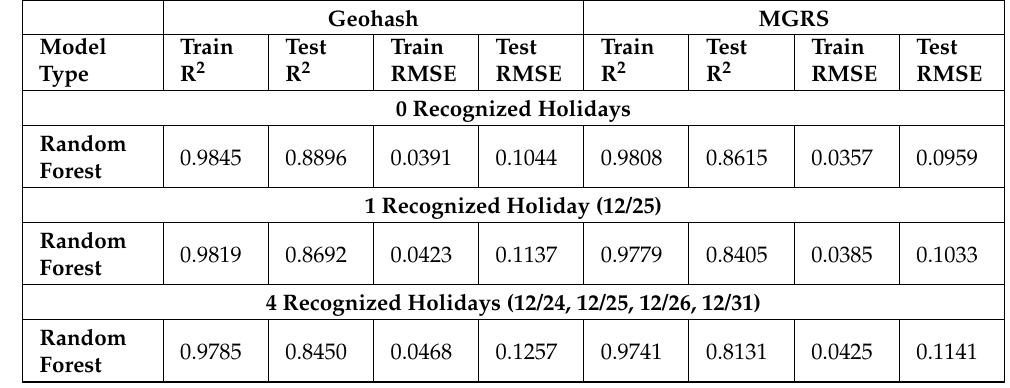
Table 9. Results from randomized 80/20 split evaluation.